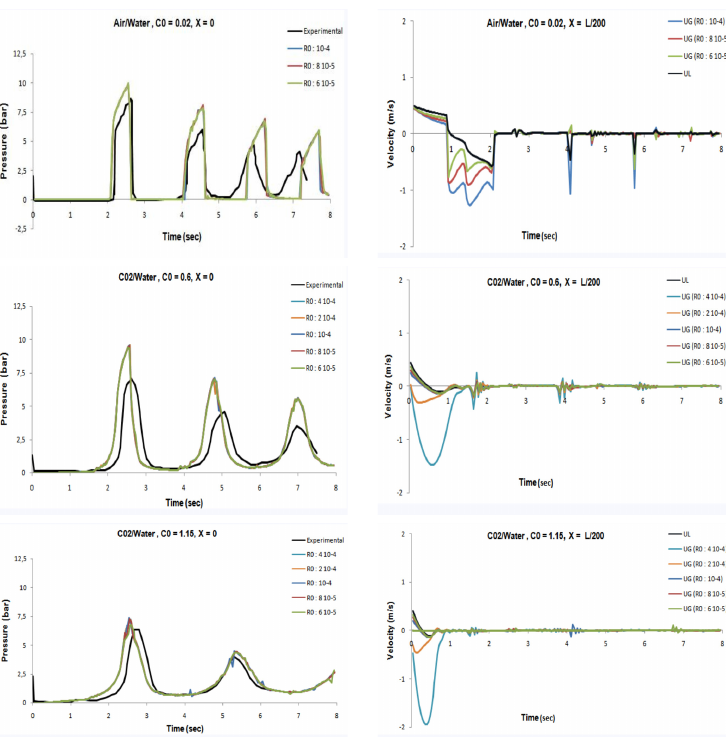
Figure 4. Variations of pressure and velocities for an upstream closing